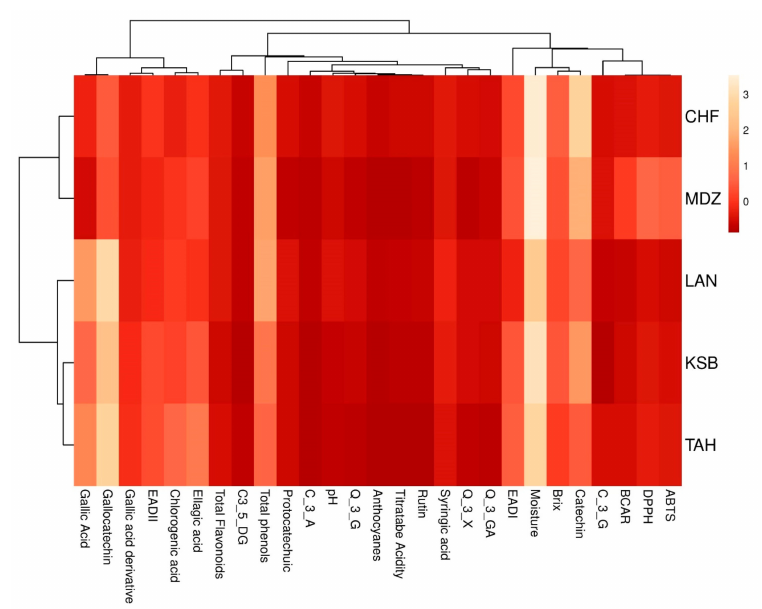
Figure 4. Two-dimensional hierarchically clustered heatmap based on the correlation distance of physicochemical and biochemical traits of